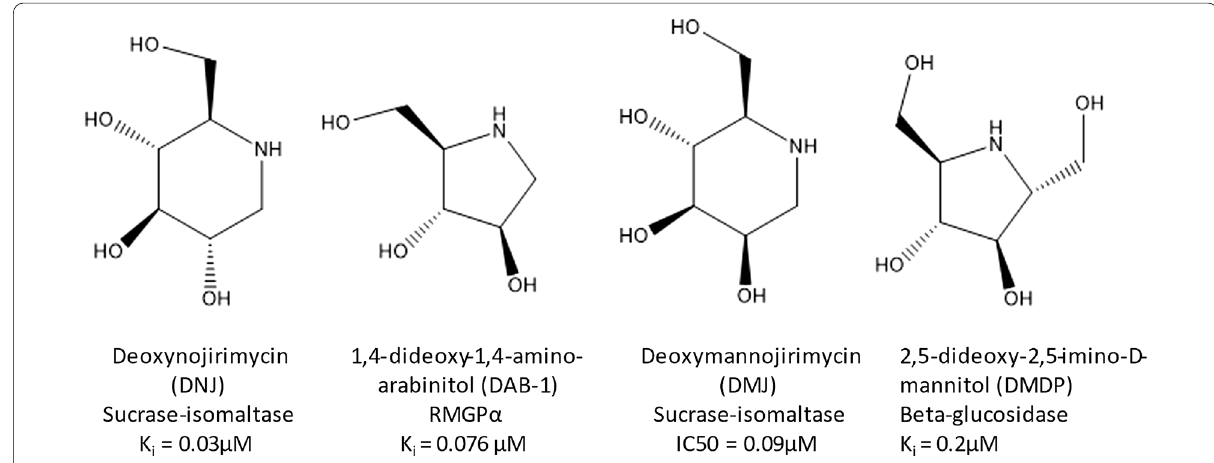
Fig. 1 Microbial azasugars and examples of glycosidases they inhibit